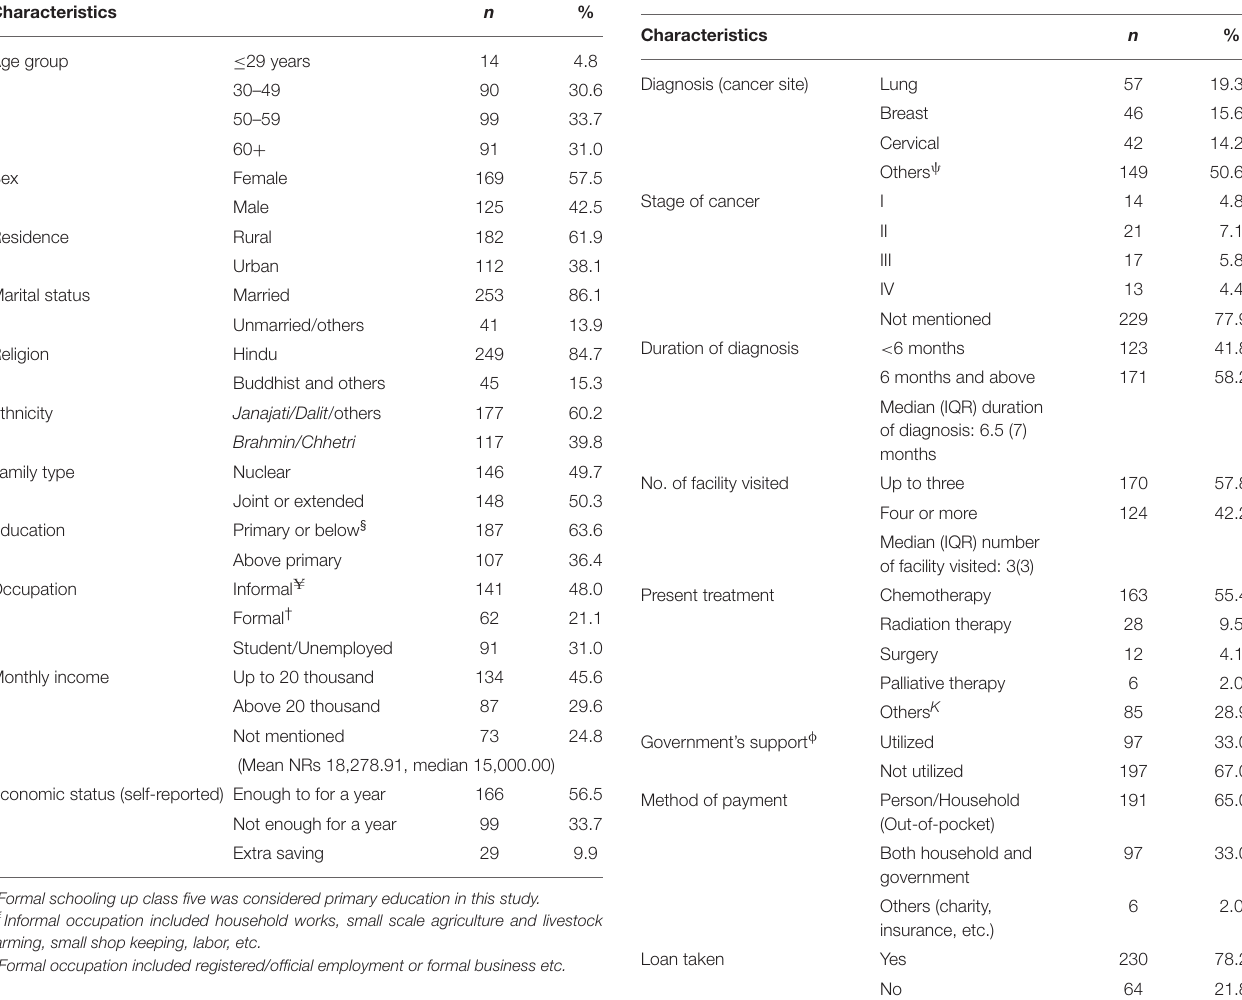
TABLE 2 | Characteristics related to disease, payment mechanism and experience of financial hardship of the participants ( n = 294). Characteristics